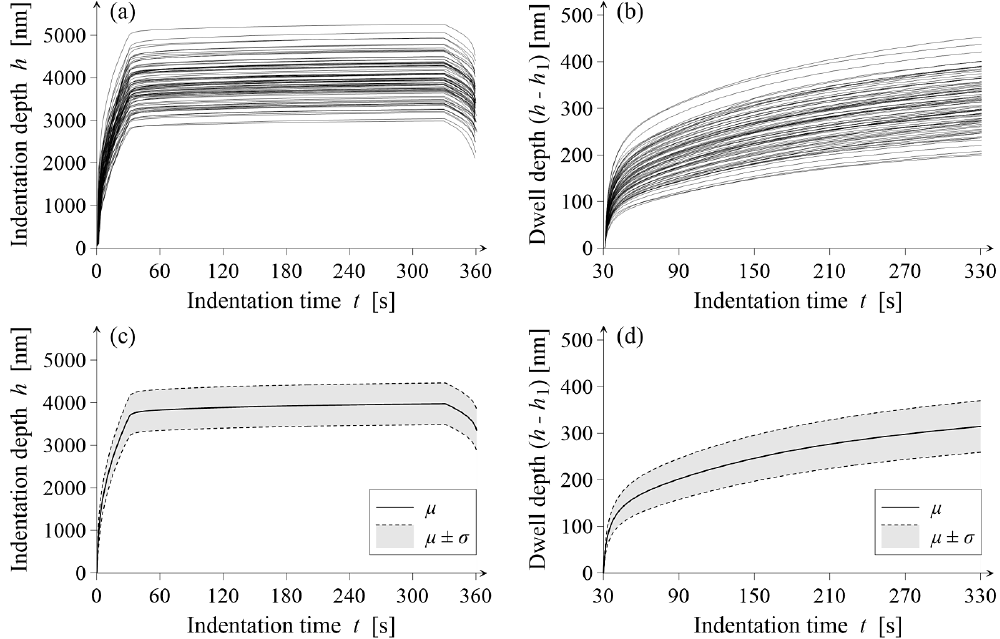
Figure 8. ( a ) Indenter immersion curves for all the indentation phases, ( b ) indenter immersion curves for the creep phase only, ( c ) mean ( µ ) indenter immersion for all the indentation phases ( σ means one standard deviation), and ( d ) average immersion for the creep phase only. Reference sample S0. In turn, Figures 9 – 11 show a comparison of the average indenter immersion during all the indentation phases as well as in the creep phase only for series S0 and S1, S0 and S2, and S0 and S3, respectively.